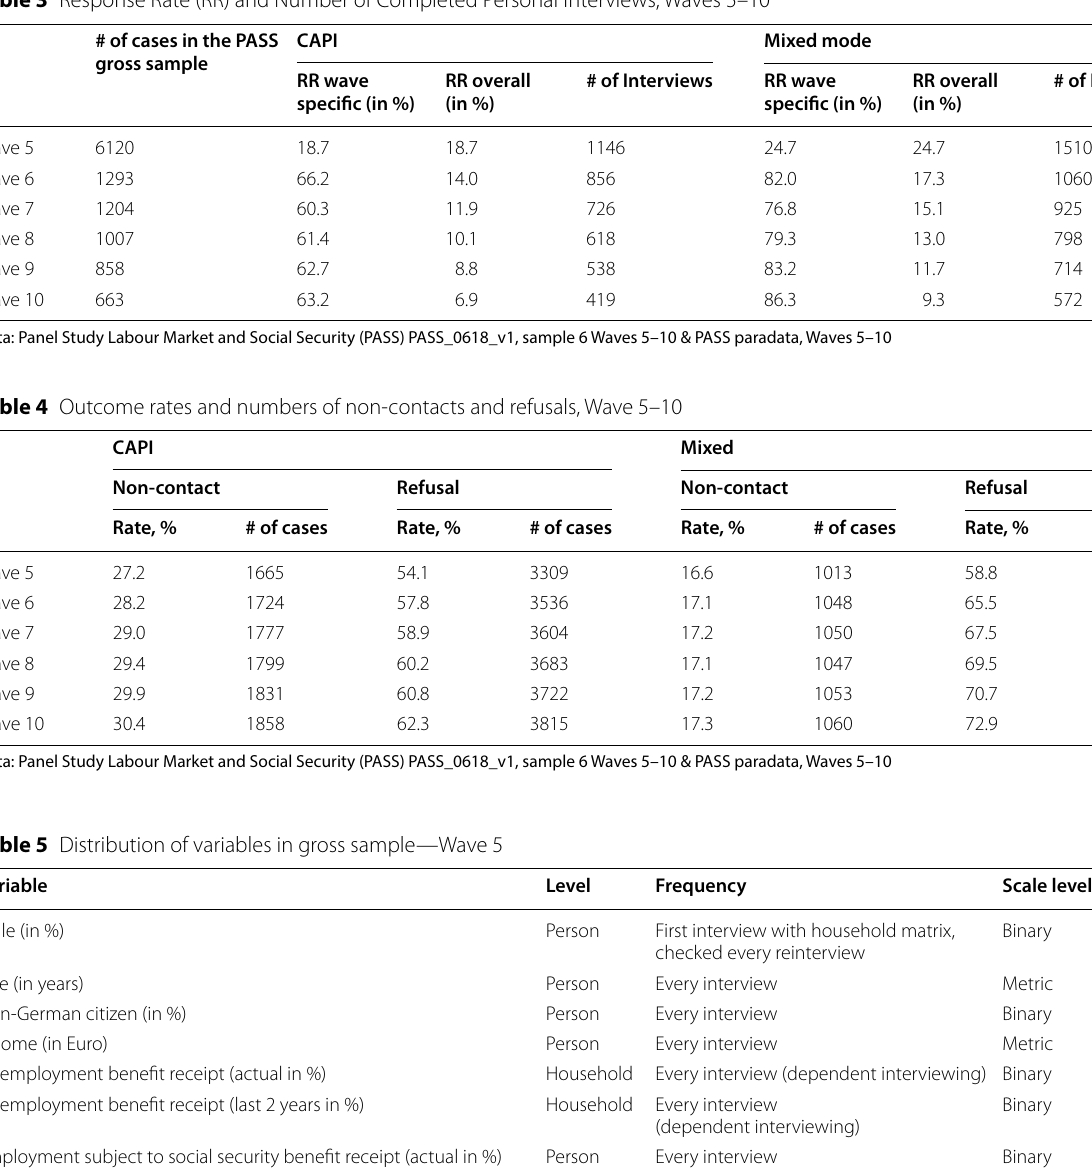
Table 3 Response Rate (RR) and Number of Completed Personal Interviews, Waves 5–10